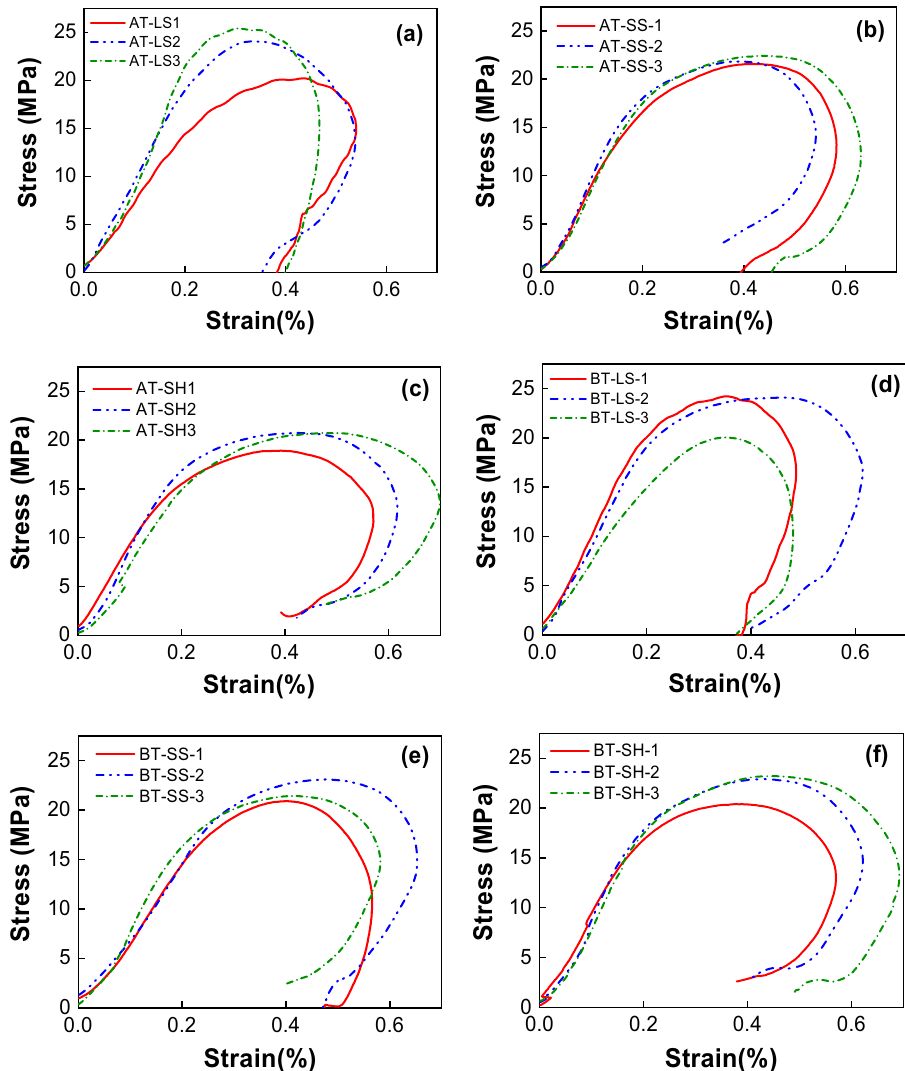
Figure 9. Dynamic stress–strain curves of different types of combined coal–rock bodies. ( a ) Anthracite— limestone, ( b ) anthracite—sandstone, ( c ) anthracite—shale, ( d ) bituminous coal—limestone, ( e ) bituminous coal—sandstone, ( f ) bituminous coal